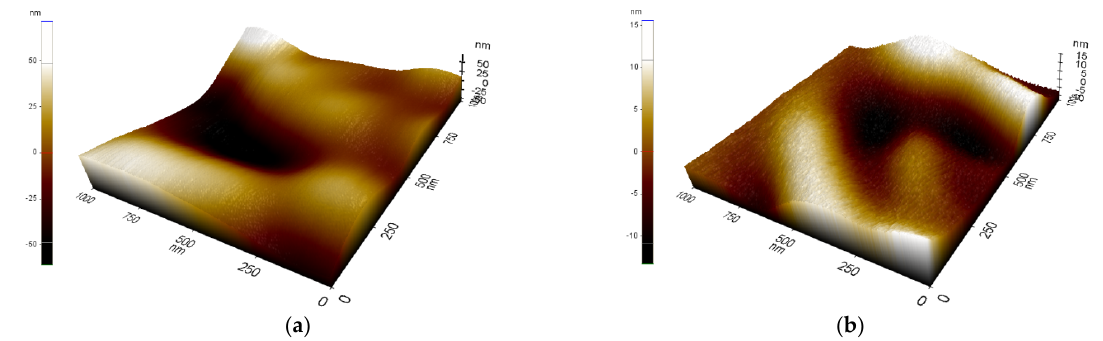
Figure 7. Atomic force microscopy (AFM) images of the ( a ) bare Al 2 O 3 membrane and ( b ) Poly(oxyethylene methacrylate) (POEM)-directed TiO 2 film on the Al 2 O 3 membrane.